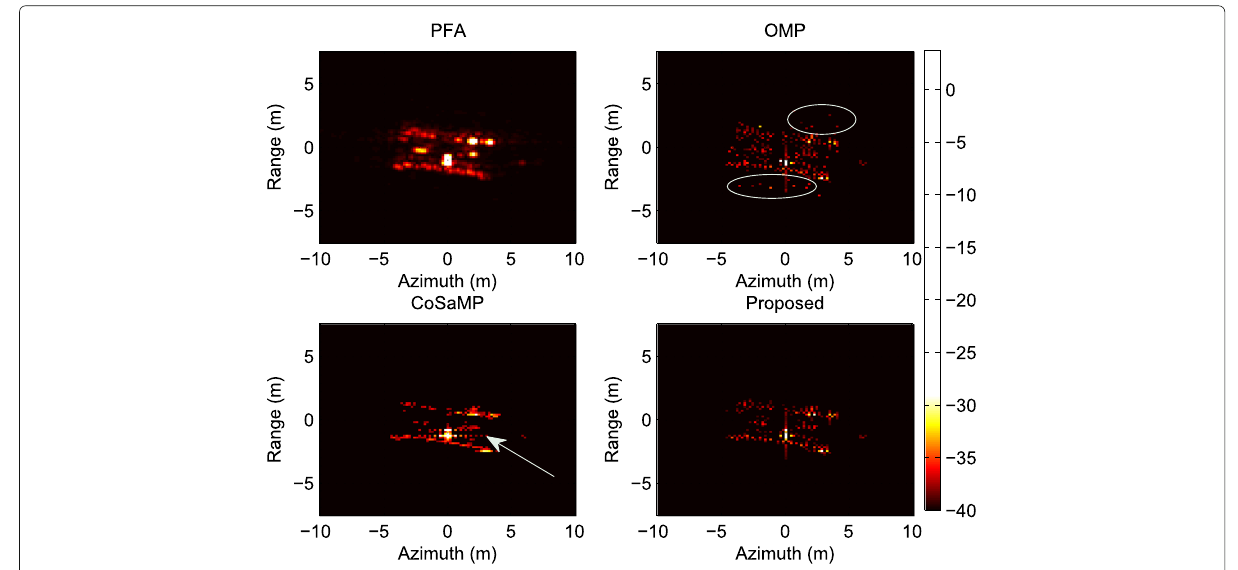
Fig. 4 SAR imaging for practical measured data, φ = 80